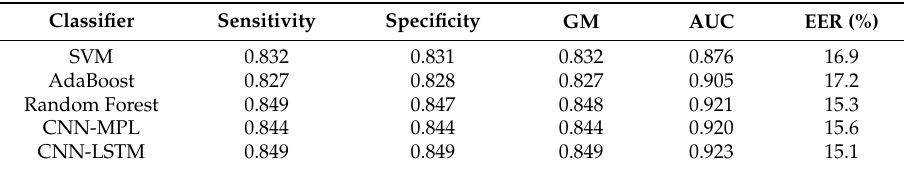
Table 6. LOSO evaluation results of the supervised classification models with a data representation of 64-bin FFT and overlap